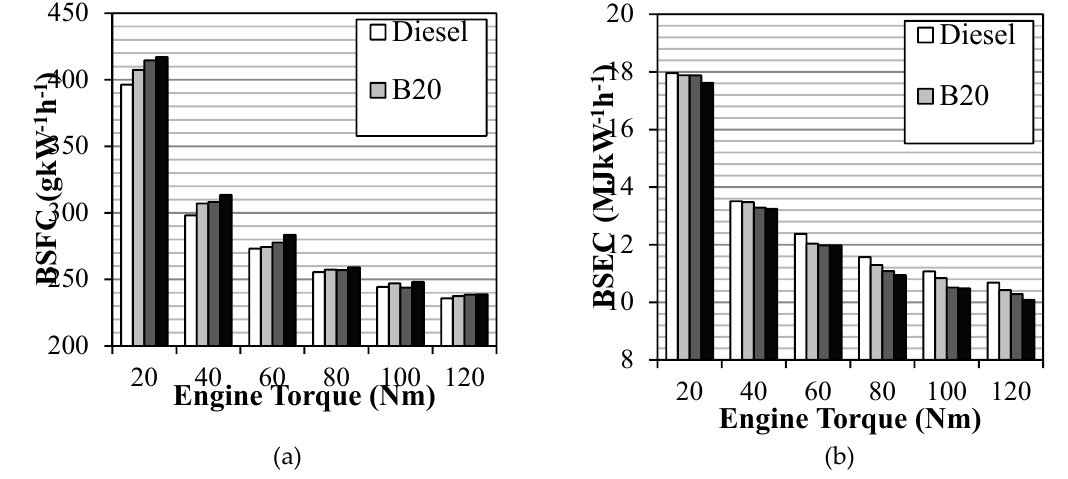
Figure 2. ( a ) BSFC and ( b ) BSEC for the tested fuels at di ff erent engine